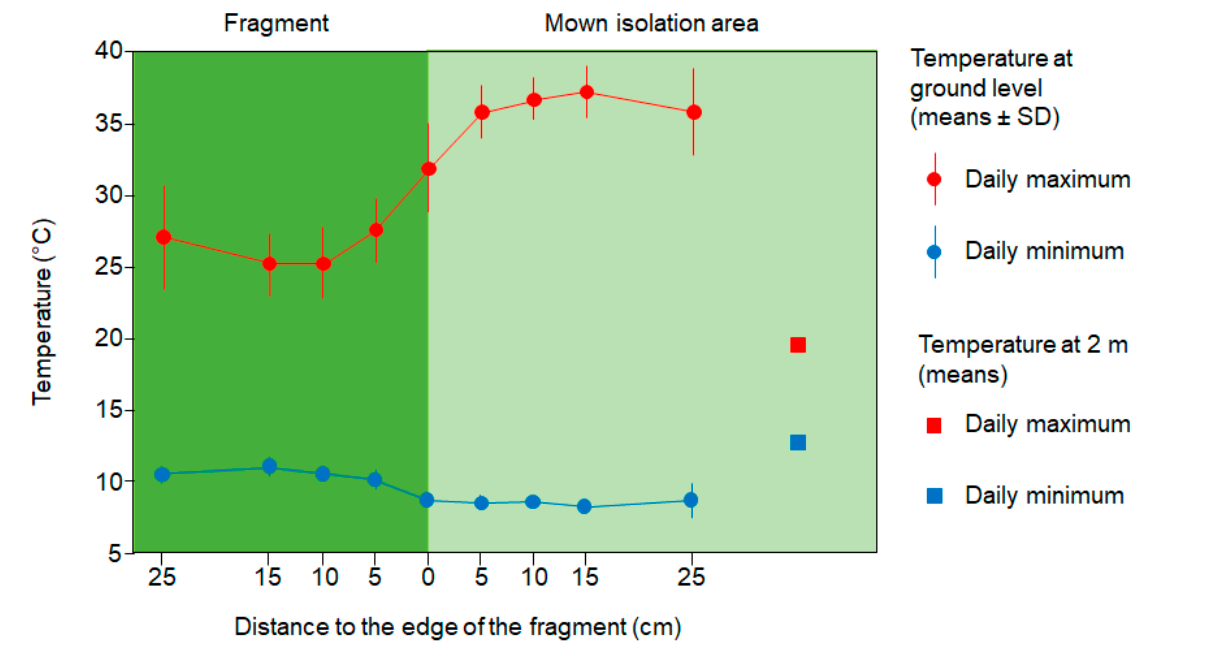
Figure 3. Temperature difference between fragments (green) and the mown isolation area (light green). Air temperature close to the ground was measured at different distances to the fragment edge both inside and outside large fragments in Vicques. Temperature was recorded every 10 min along six logger transect lines from 31 August to 12 September 1995, a period with no rain. For comparison, air temperature at 2 m above ground was measured nearby inside a shaded box. Red dots display mean daily maximum temperature (with SD), while blue dots refer to mean daily minimum temperature. Redrawn from Zschokke et al. [28].